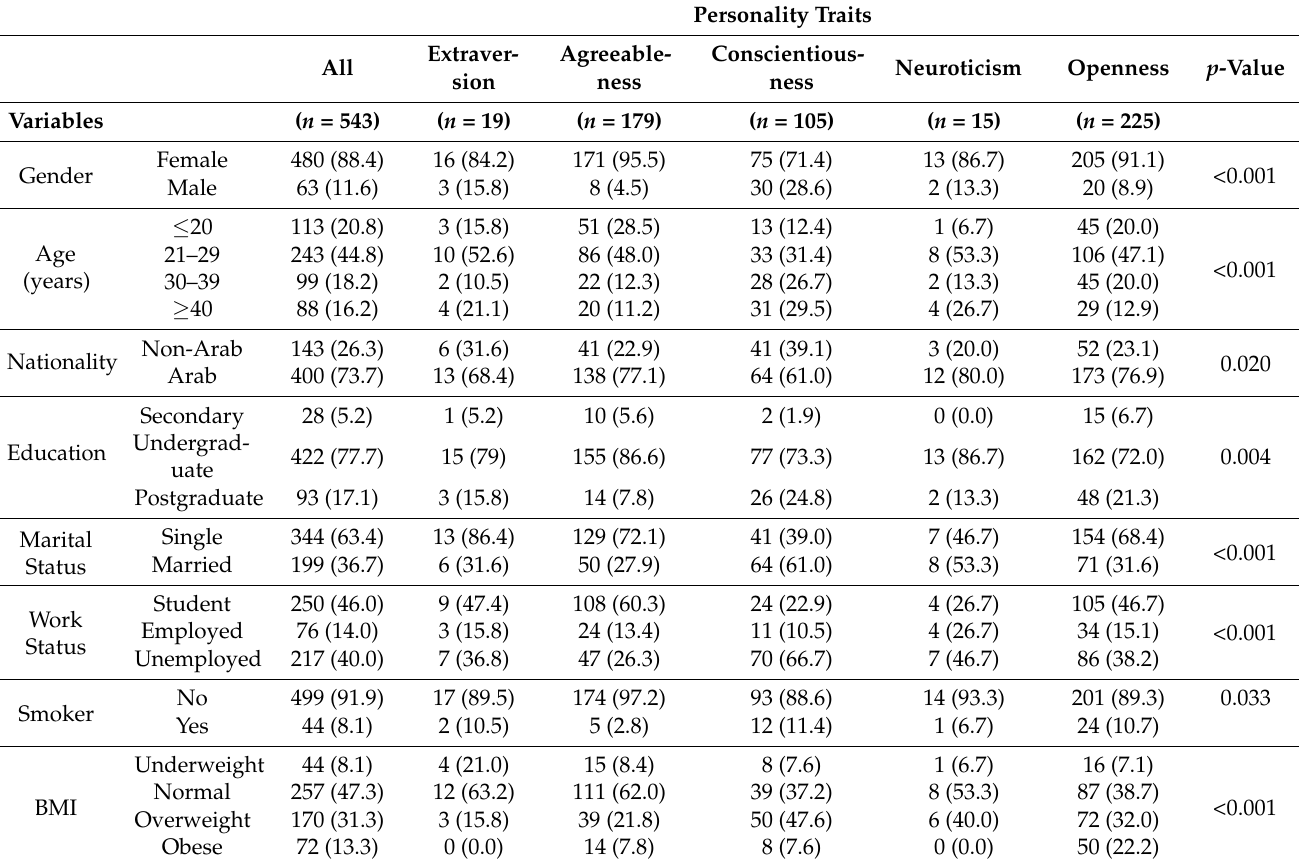
Table 1. Characteristics of the studied population by personality during the COVID-19 lockdown. Personality Traits